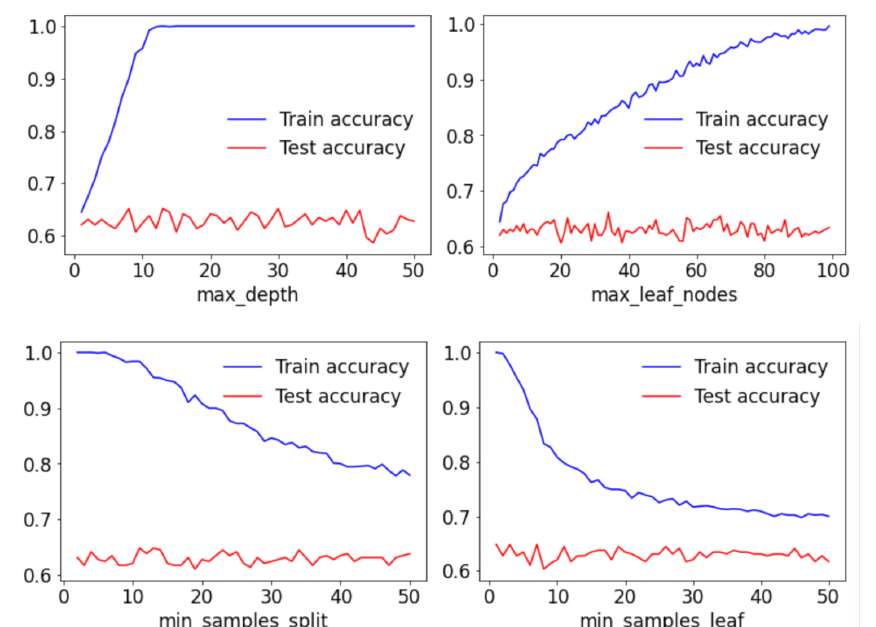
Figure 7. Training and test set accuracies as a function of the parameters max_depth, max_leaf_node, min_sample_split, and min_samples_leaf, presented in the x-axis of each plot. The parameter max_depth is the maximum depth of each tree, max_leaf_nodes is the maximum leaf nodes in each tree, min_sample_split is the minimum number of samples required to split an internal node, and min_samples_leaf is the minimum number of samples required at the leaf